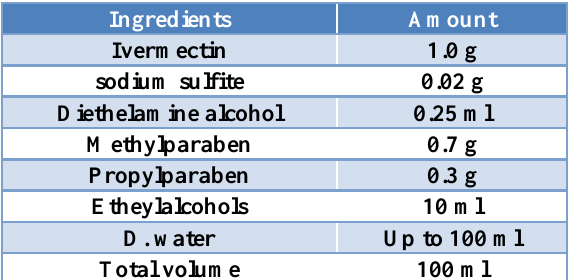
Table, 1: Physical and pharmacological properties of drug formulae ingredients.